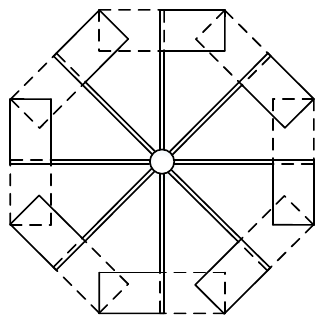
Fig. 4. Antenna element.